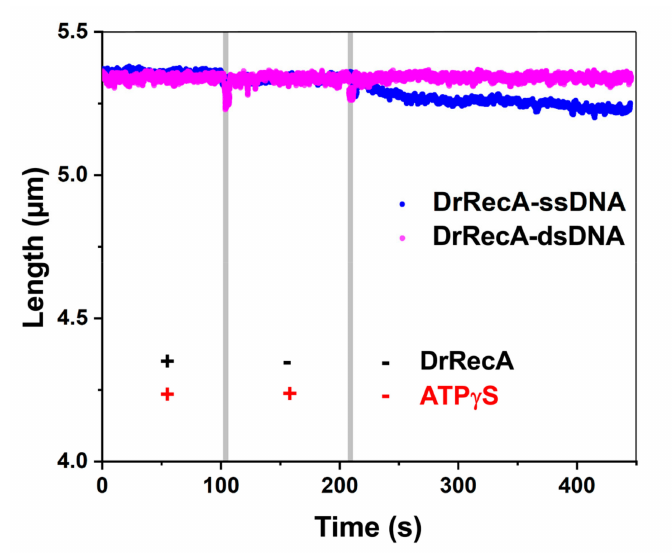
Figure 4. Dynamics of DrRecA filaments formed in the presence of ATP γ S on ssDNA (blue) and dsDNA (magenta) under a stretching force of 3 pN, sequentially incubated in the channel containing both DrRecA and ATP γ S, the channel with only ATP γ S, and the channel lacking both DrRecA and ATP γ S. Gray vertical lines indicate moments the DNA tether was transferred between corresponding